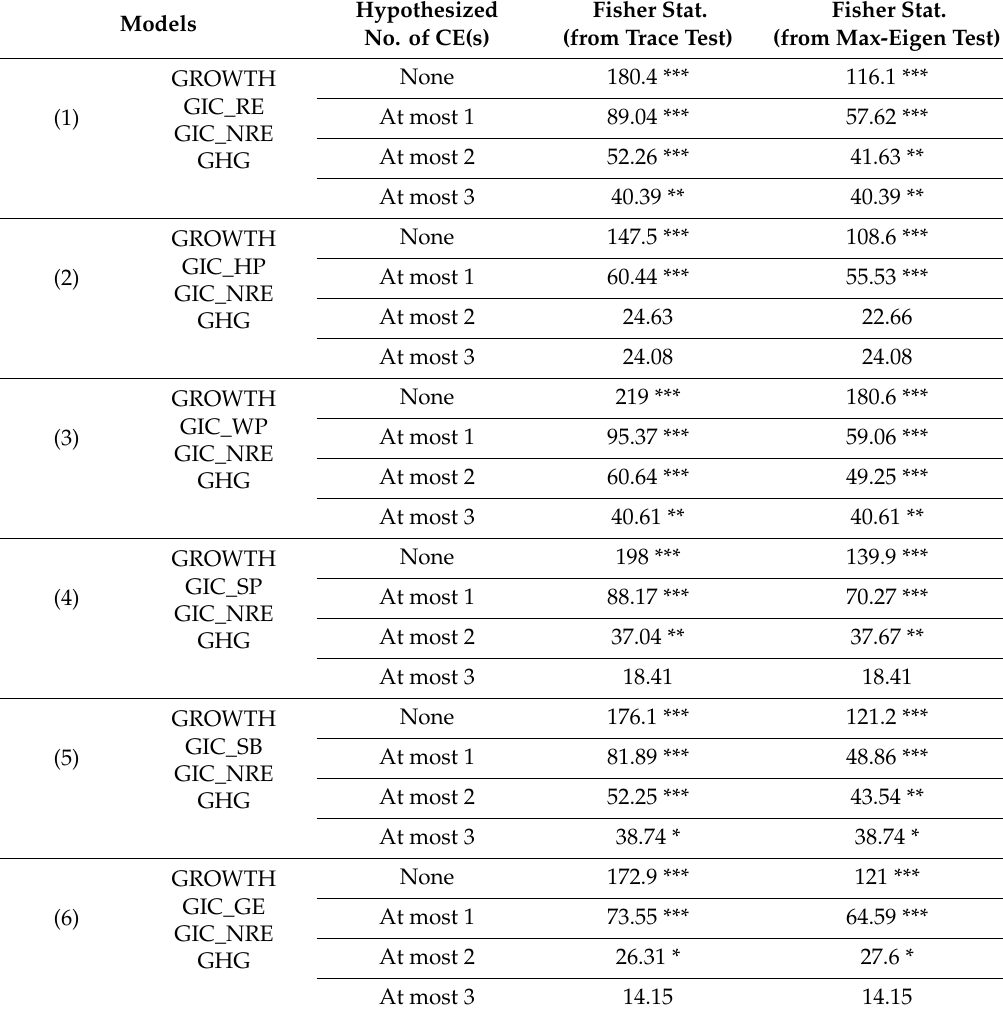
Table 13. Fisher (combined Johansen) panel cointegration test results.